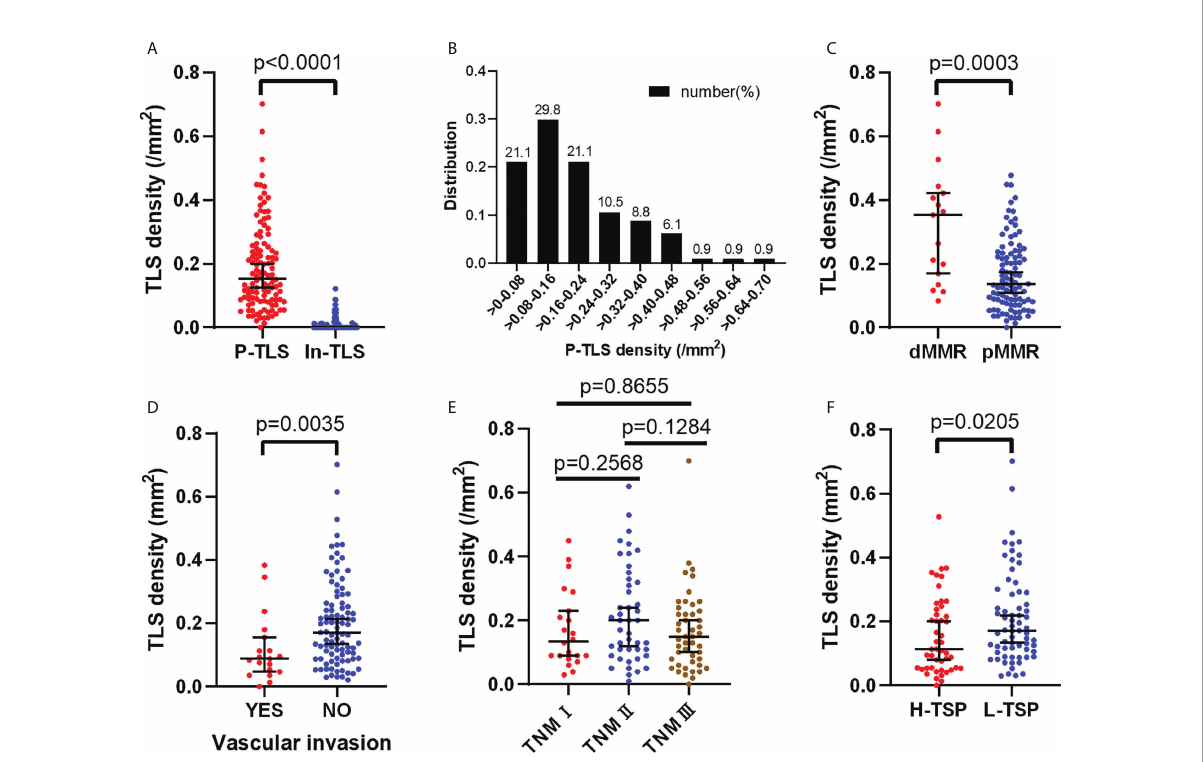
FIGURE 3 Distribution of P-TLS density and its relationship with clinical features in the training set. (A) Relationship between P-TLS density and In-TLS density; (B) Distribution of P-TLS density; (C – F) Relationship between P-TLS density and MMR/Vascular invasion/TNM